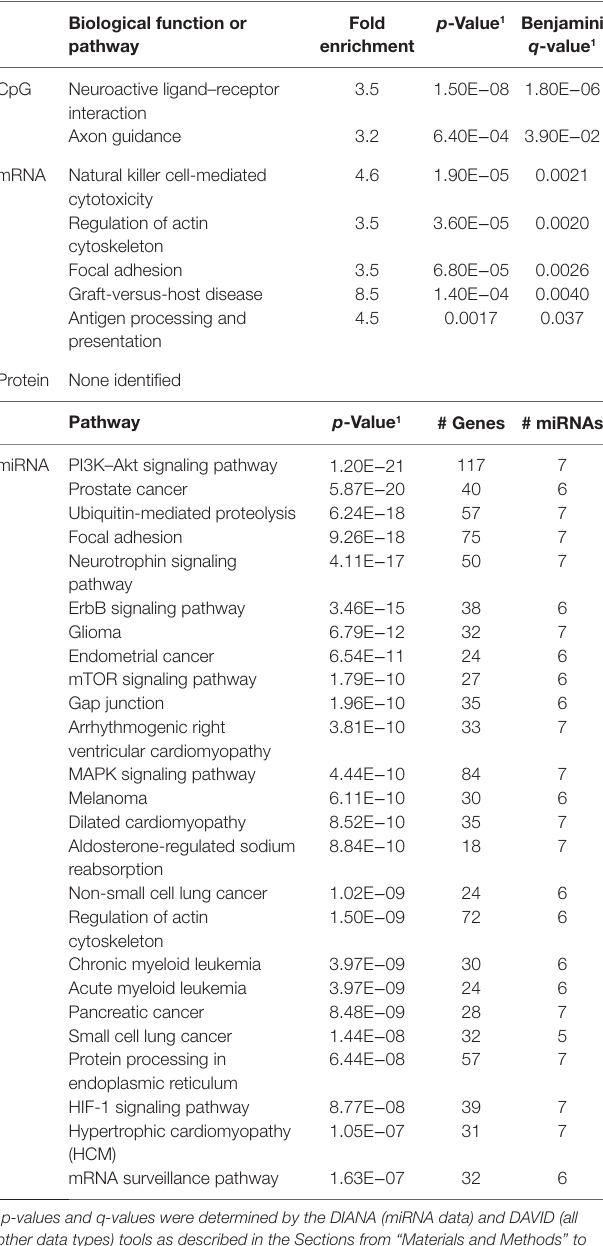
TaBle 6 | Biological functions correlated with percentage of cD8 + cD28 −